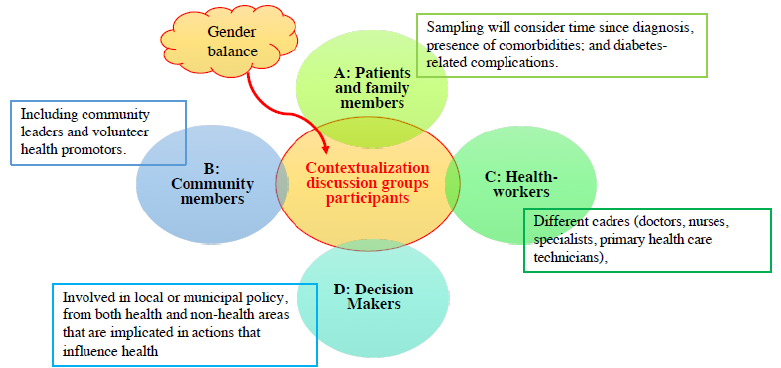
Figure 2. Purposive sampling of participants for contextualization discussion